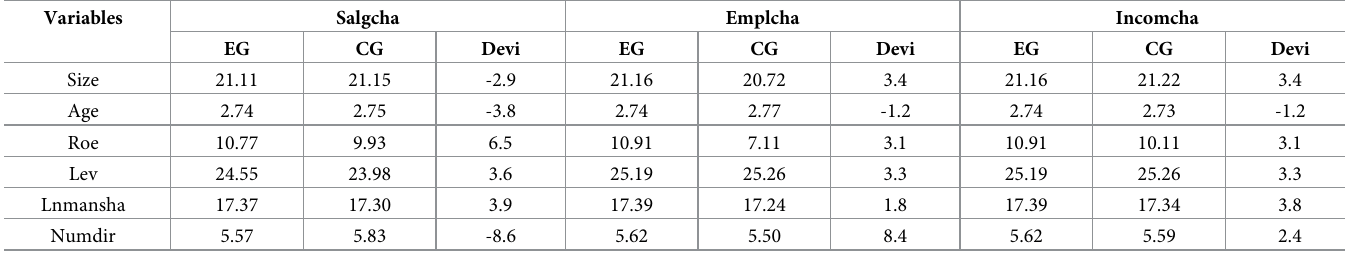
Table 5. Matching balance test